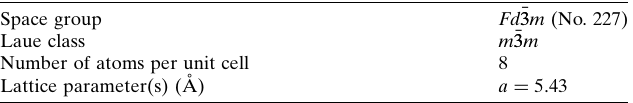
Table 2 The structure of silicon used for the calculations.